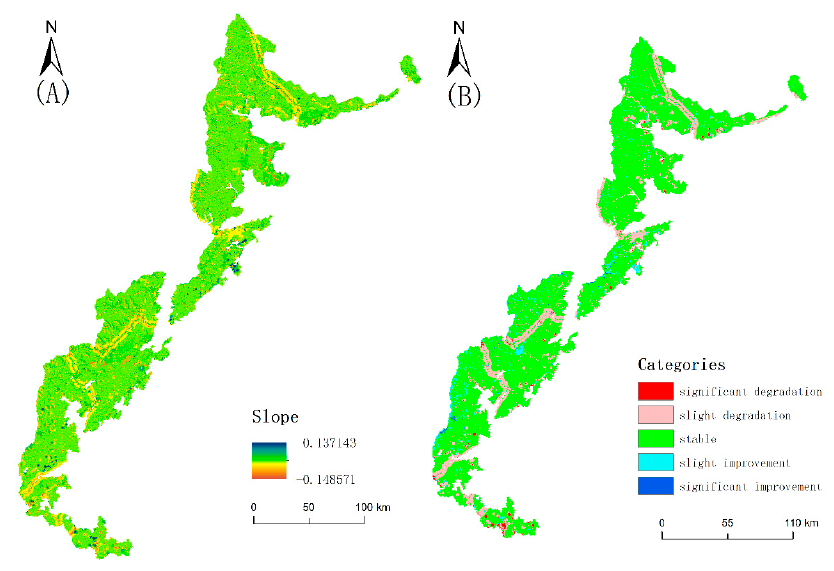
Figure 6. Characteristics of the ecological intactness change of GPNP from 1980 to 2020.